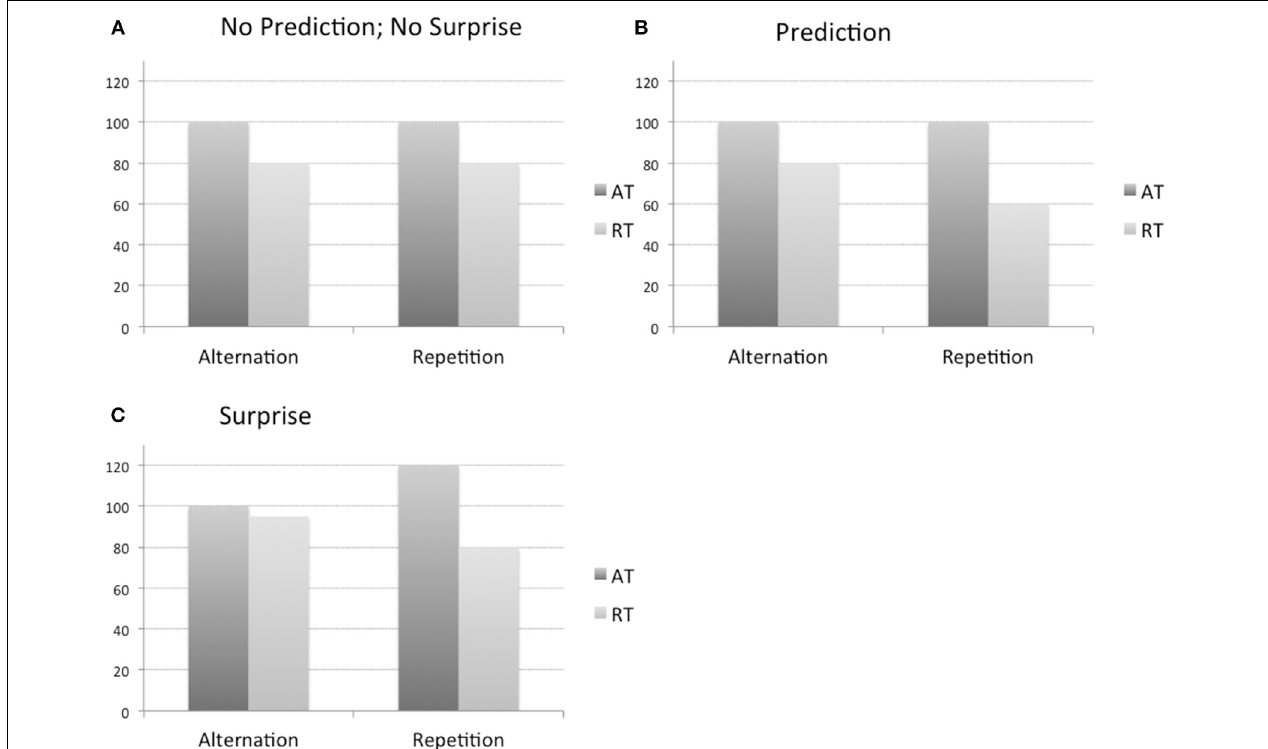
FIGURE 1 | Schematic illustrations of how top-down modulations (predictions and surprise-related) might affect neural responses. Hypothetical fMRI response is depicted separately for the blocks with low probability of repetitions (Alternation) and high probability of repetitions (Repetition). (A) Repetition suppression is independent of predictions or surprise. (B) Repetition suppression is enhanced for expected, repeated stimuli. (C) Responses are enhanced for surprising stimuli. Results for face stimuli (FFA, OFA), objects (macaque IT and LO), outlines of objects (left and right LO), and roman letters (LFA, LO) are mentioned only. FFA, fusiform face